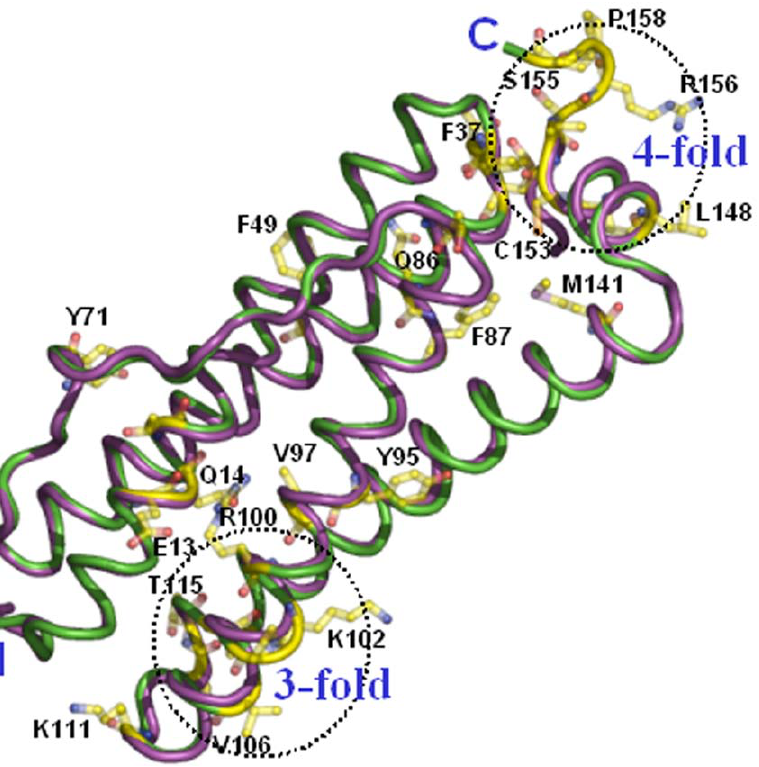
Figure 10. Unique regions specific to Mtb BfrA. Mapping of unique and conserved residues in mycobacteria. Residues unique to mycobacterial species (depicted by gray boxes in the sequence alignment figure 9) are labeled and depicted as sticks (in atom color) on cartoon representation of Mtb SeMet-BfrA monomer (green). The E. coli BfrA monomer (1bcf:I; violet cartoon) is also superimposed to illustrate a dissimilar C-terminus.